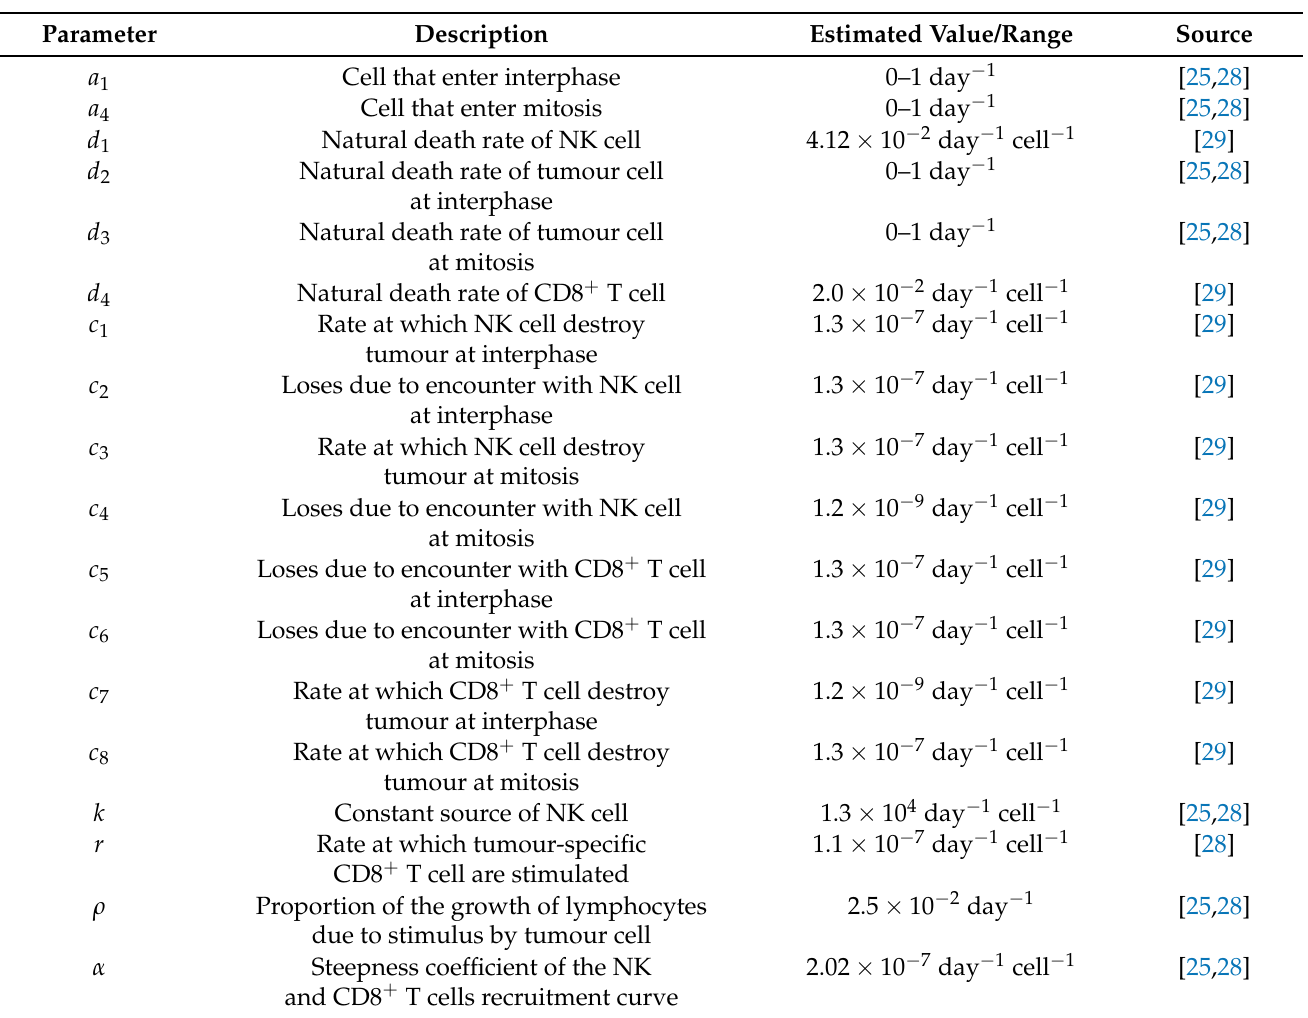
Table 1. Parameter